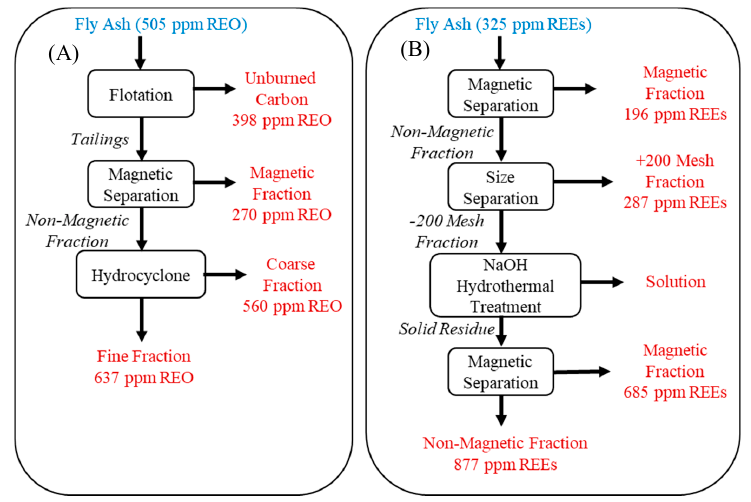
Figure 5. Flowsheet reported in the literature for REE pre-concentration using physical methods: ( A ) reported by [83] and ( B ) reported by [76].